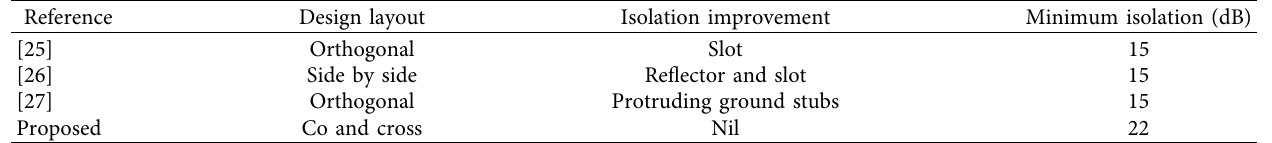
Table 3: Comparison of the proposed design with other